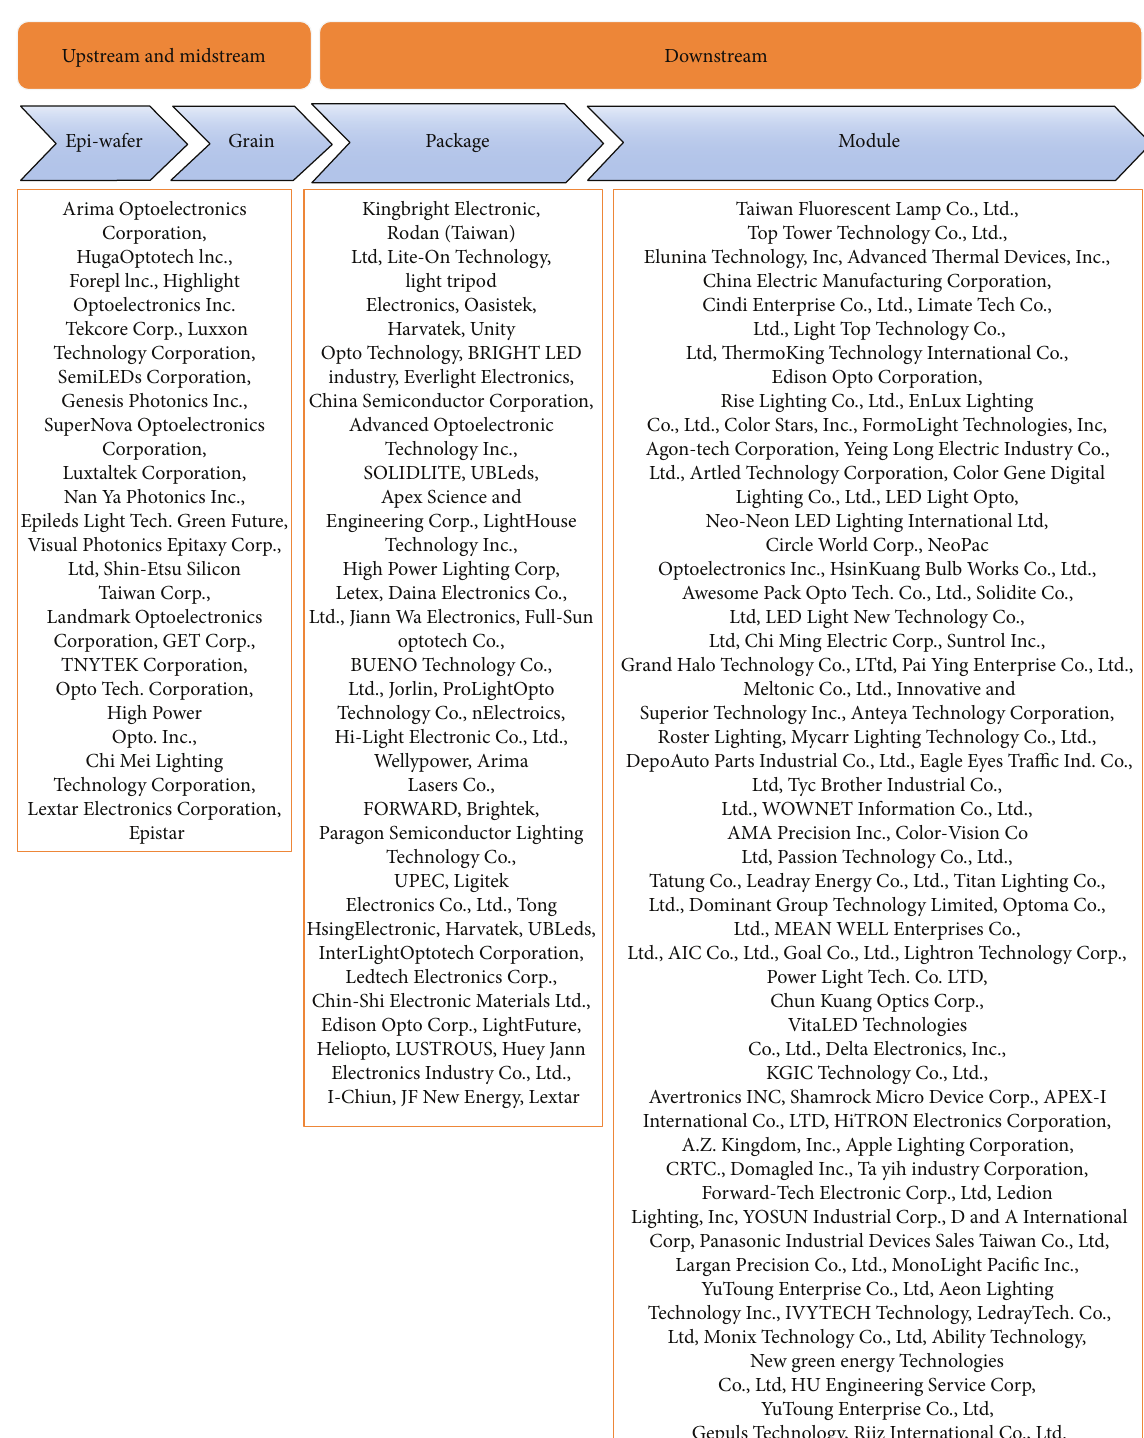
Figure 5: Value chain of Taiwanese LED industry. Source: this